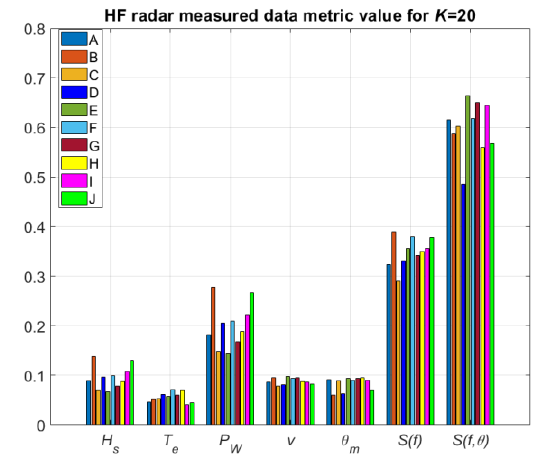
Fig. 4. Metric for HF radar data from method A to J.